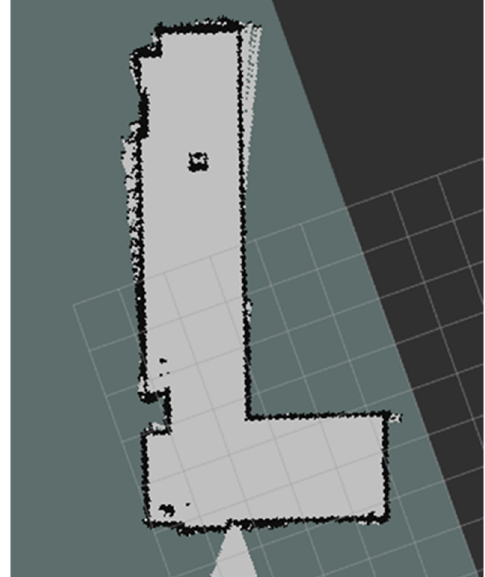
Figure 22. “ L” shaped corridor map. Figure 22. “L” shaped corridor map.